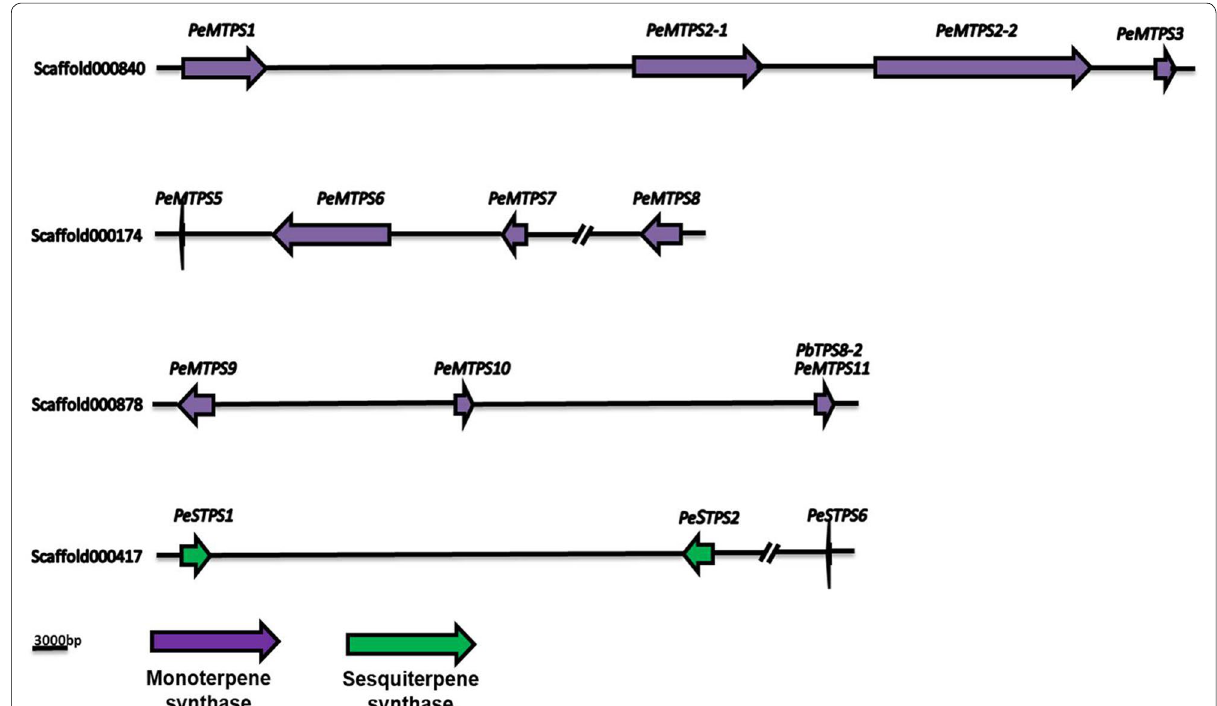
Fig. 4 TPS of P. equestris form several clusters. The genes are located on the scaffolds which is form from the assembly of the P. equestris genome. The arrow direction shows the translation direction of genes, yellow arrow indicated the monoterpene synthase and green arrow represented sesquiterpene synthase